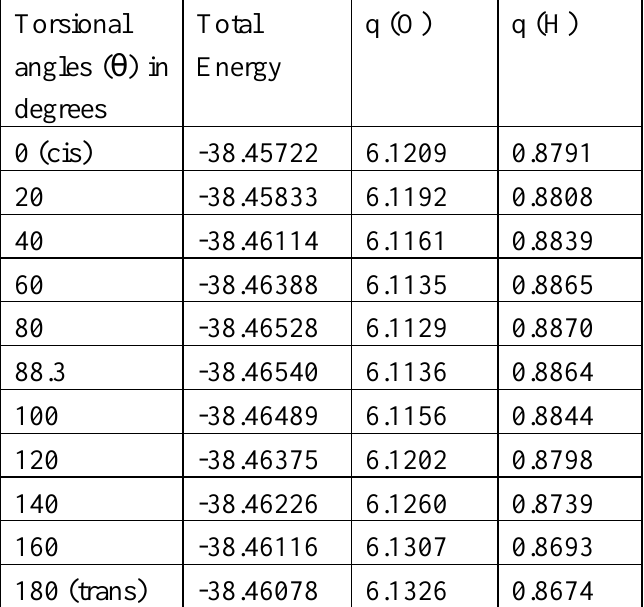
O as a function of torsional 2 2